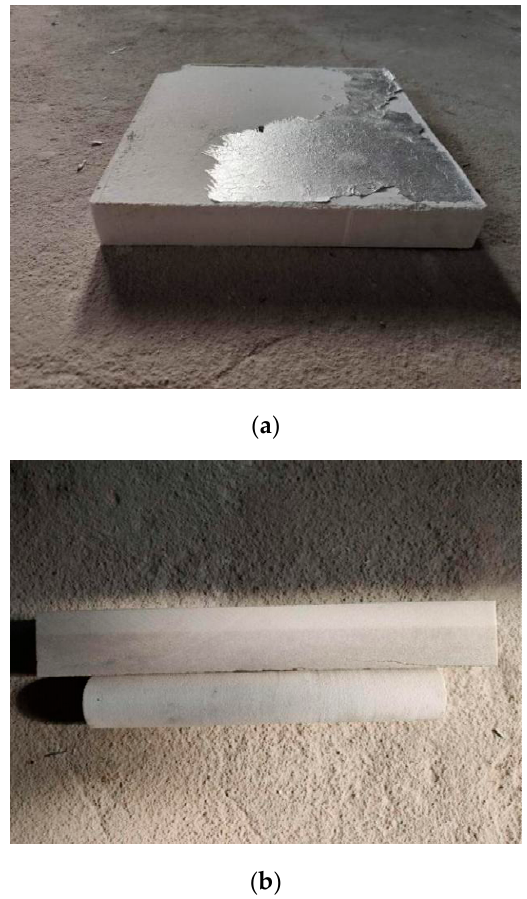
Figure 5. ( a ) A 30 cm × 30 cm × 7 cm synthetic sandstone block; ( b ) cored/squared synthetic sandstone samples.